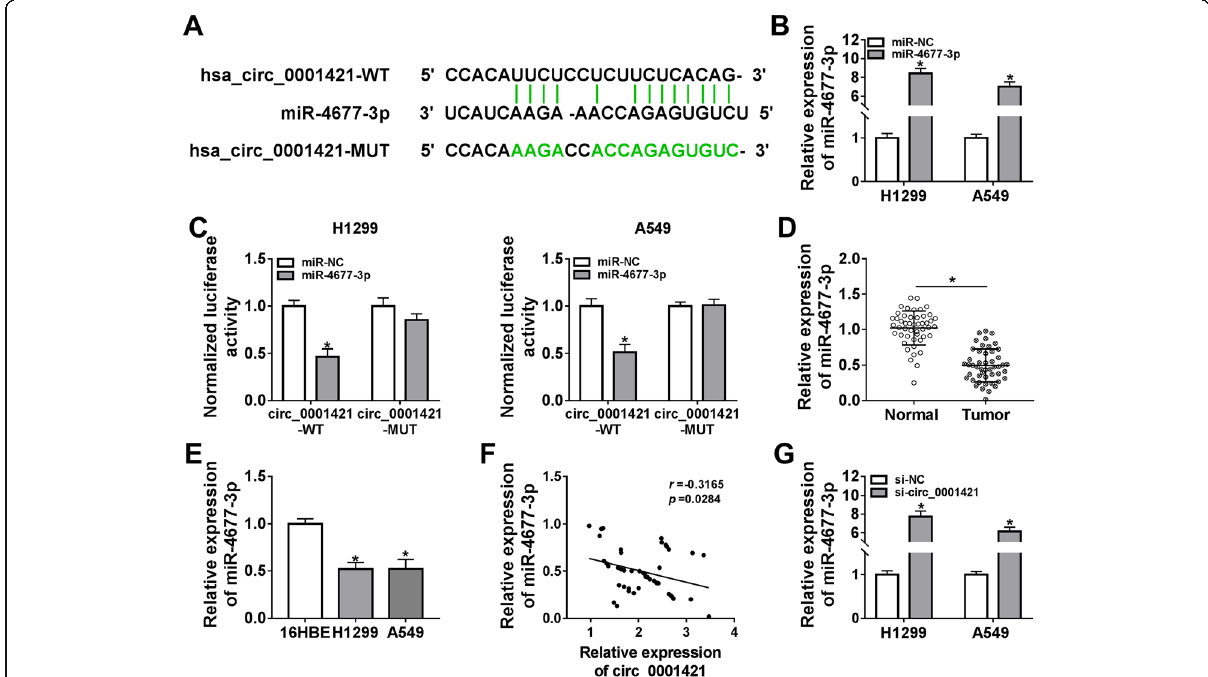
Fig. 3 Circ_0001421 could act as a sponge for miR-4677-3p. a The predicted binding sites between circ_0001421 and miR-4677-3p were shown. b The expression of miR-4677-3p in H1299 and A549 cells transfected with miR-NC or miR-4677-3p was detected by qRT-PCR. (C) Dual-luciferase reporter assay was performed to verify the relationship between circ_0001421 and miR-4677-3p in H1299 and A549 cells. d miR-4677-3p expression in tumor and adjacent normal tissues was examined by qRT-PCR. e qRT-PCR was used to determine miR-4677-3p expression in A549, H1299 and 16HBE cells. f The correlation between circ_0001421 and miR-4677-3p expression was analyzed in LC tissues by Pearson coefficient analysis. g miR-4677-3p expression in H1299 and A549 cells transfected with si-NC or si-circ_0001421 was measured by qRT-PCR. * P <